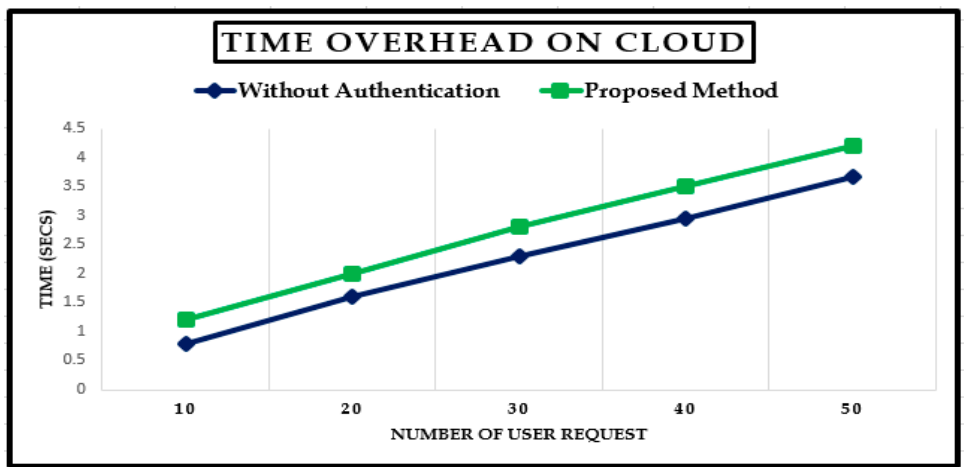
Figure 8. Average Time Overhead Based on the Number of User Requests.